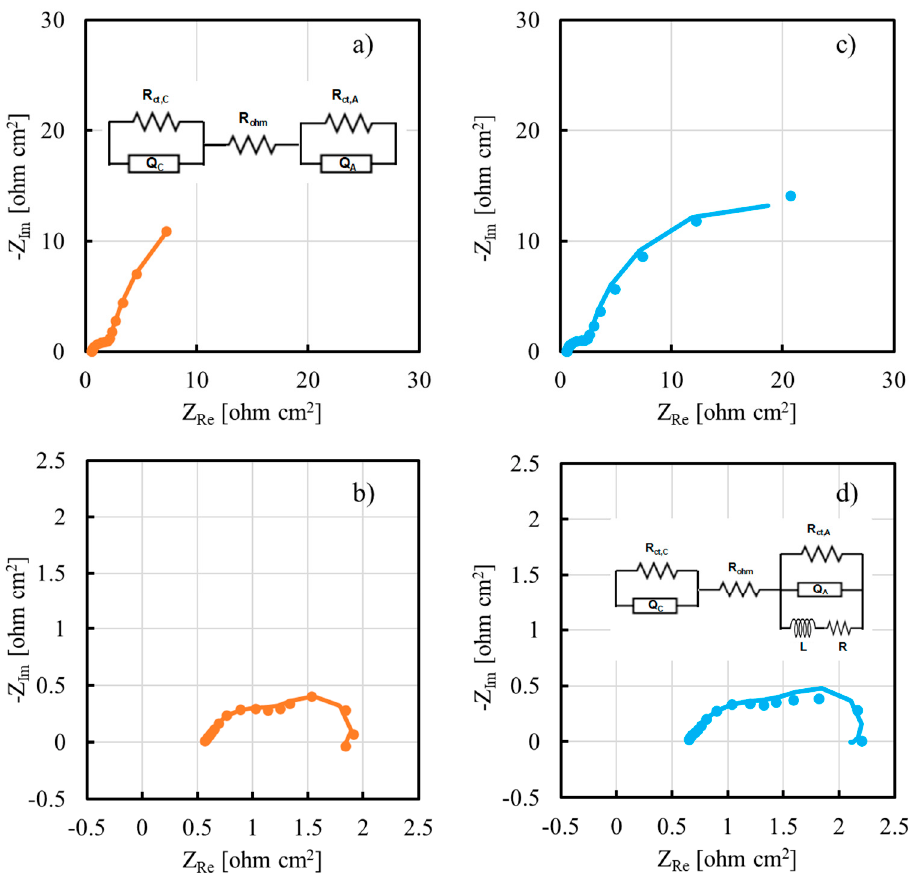
Figure 10. EIS spectra recorded at 50 ◦ C for cells employing TiO 2 (5 wt%)-containing membranes at ( a ) 550 mV and ( b ) 250 mV. EIS spectra recorded at 50 ◦ C for cells employing Al 2 O 3 (2% wt)-containing membranes at ( c ) 550 mV and ( d ) 250 mV. Continuous lines: fitting lines. Inset: equivalent electrical circuits.